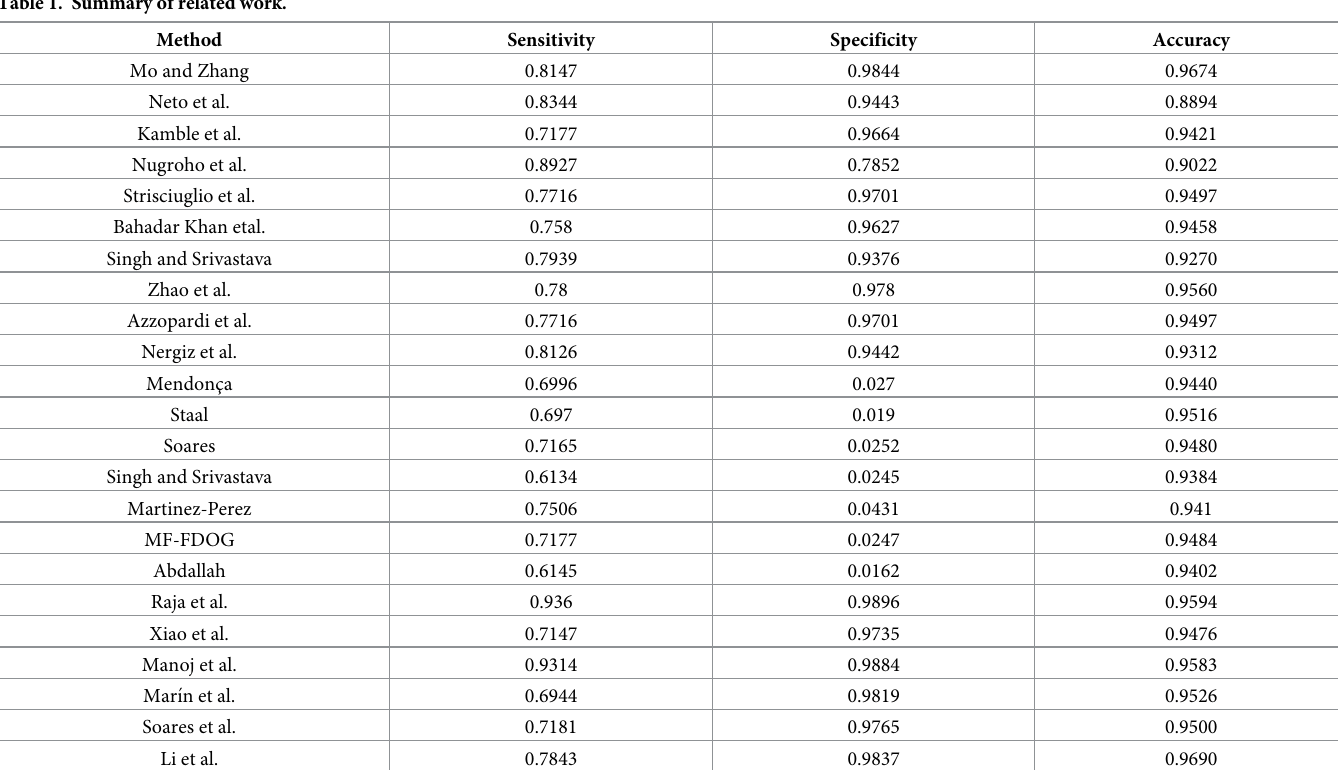
Table 1. Summary of related